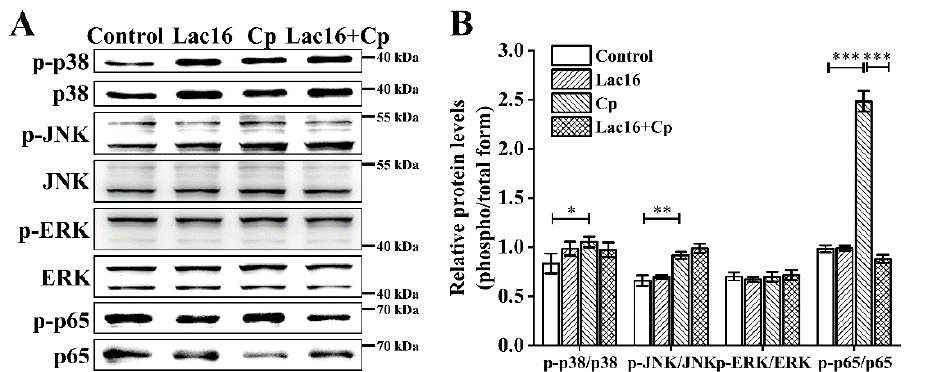
Figure 7. Western blot detection of MAPK and NF-κB pathways in IPEC-J2 cells. ( A ) Western blot analysis of MAPK and NF-κB pathways. ( B ) Quantitative analysis of the expression levels of phospho-p38/p38, phospho-JNK/JNK, phospho-ERK/ERK, and phosphor-p65/p65. Data are presented as the means ± SD for n = 3; * p < 0.05, ** p < 0.01, *** p < 0.001 ( t test).